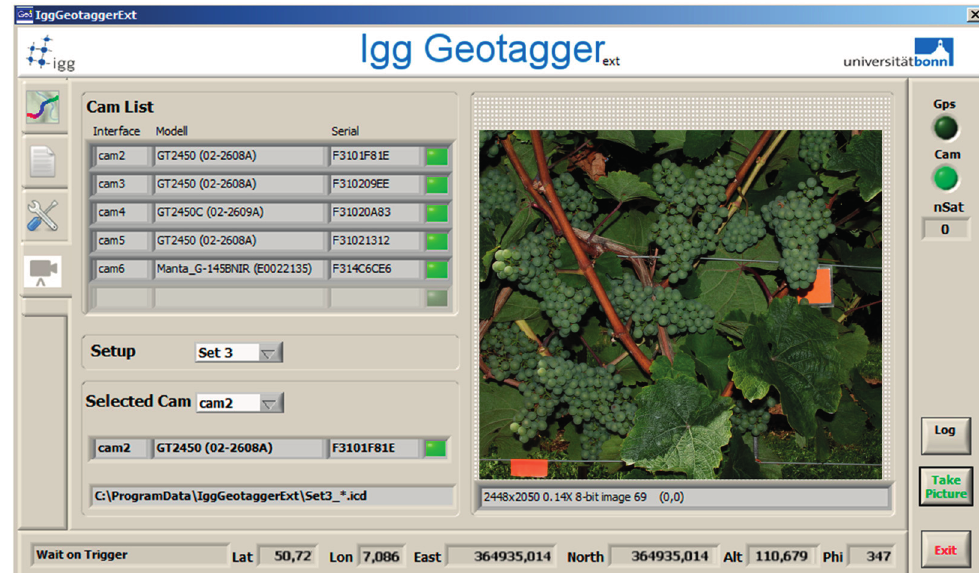
Figure 1. Graphical user interface of the IggGeotagger.Ext . The software manages the communication between the control unit of the PHENObot and the image acquisition PC, triggers the cameras and controls the image transport and storage. It is preferentially used for the visualization of captured images and for setting the camera parameters.